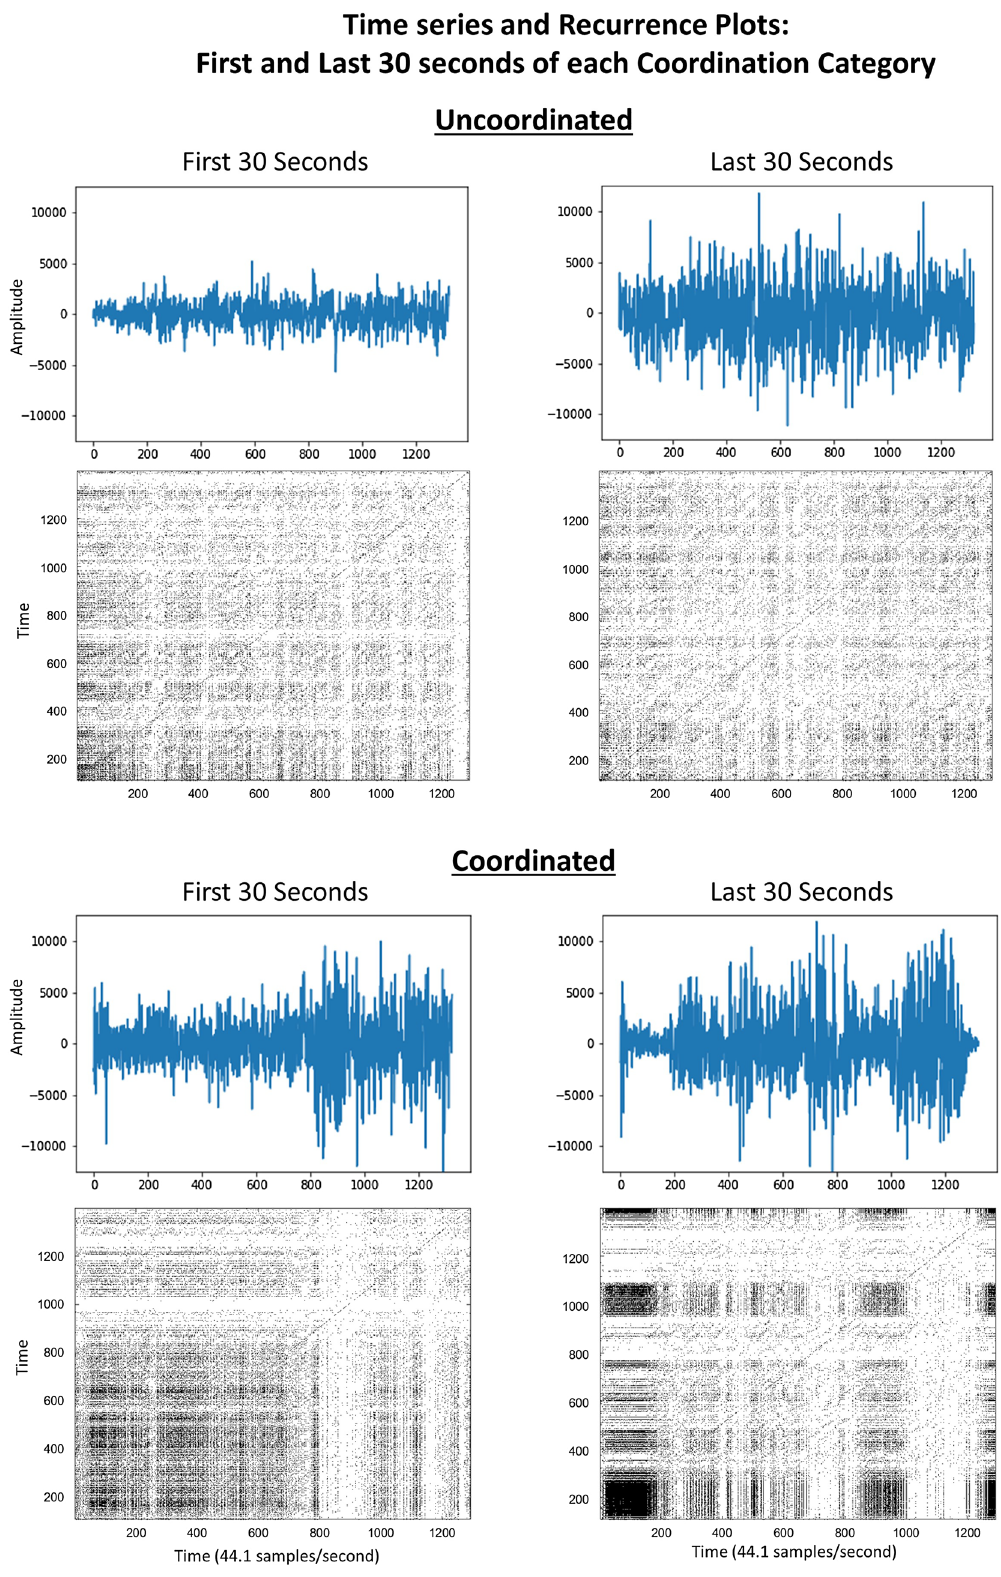
Figure 1. Time series and recurrence plots for the first and last 30 s of each Coordination Category (Uncoordinated or Coordinated). Darker segments of the recurrence plots indicate the presence of more recurrent data points. Vertical and horizontal lines indicate periods of stability in the system, where one state was visited for a period of up to a few seconds at a time. Note: 9 s of audience applause during the Introduction Performance Event were not analyzed, and are subsequently excluded from all data